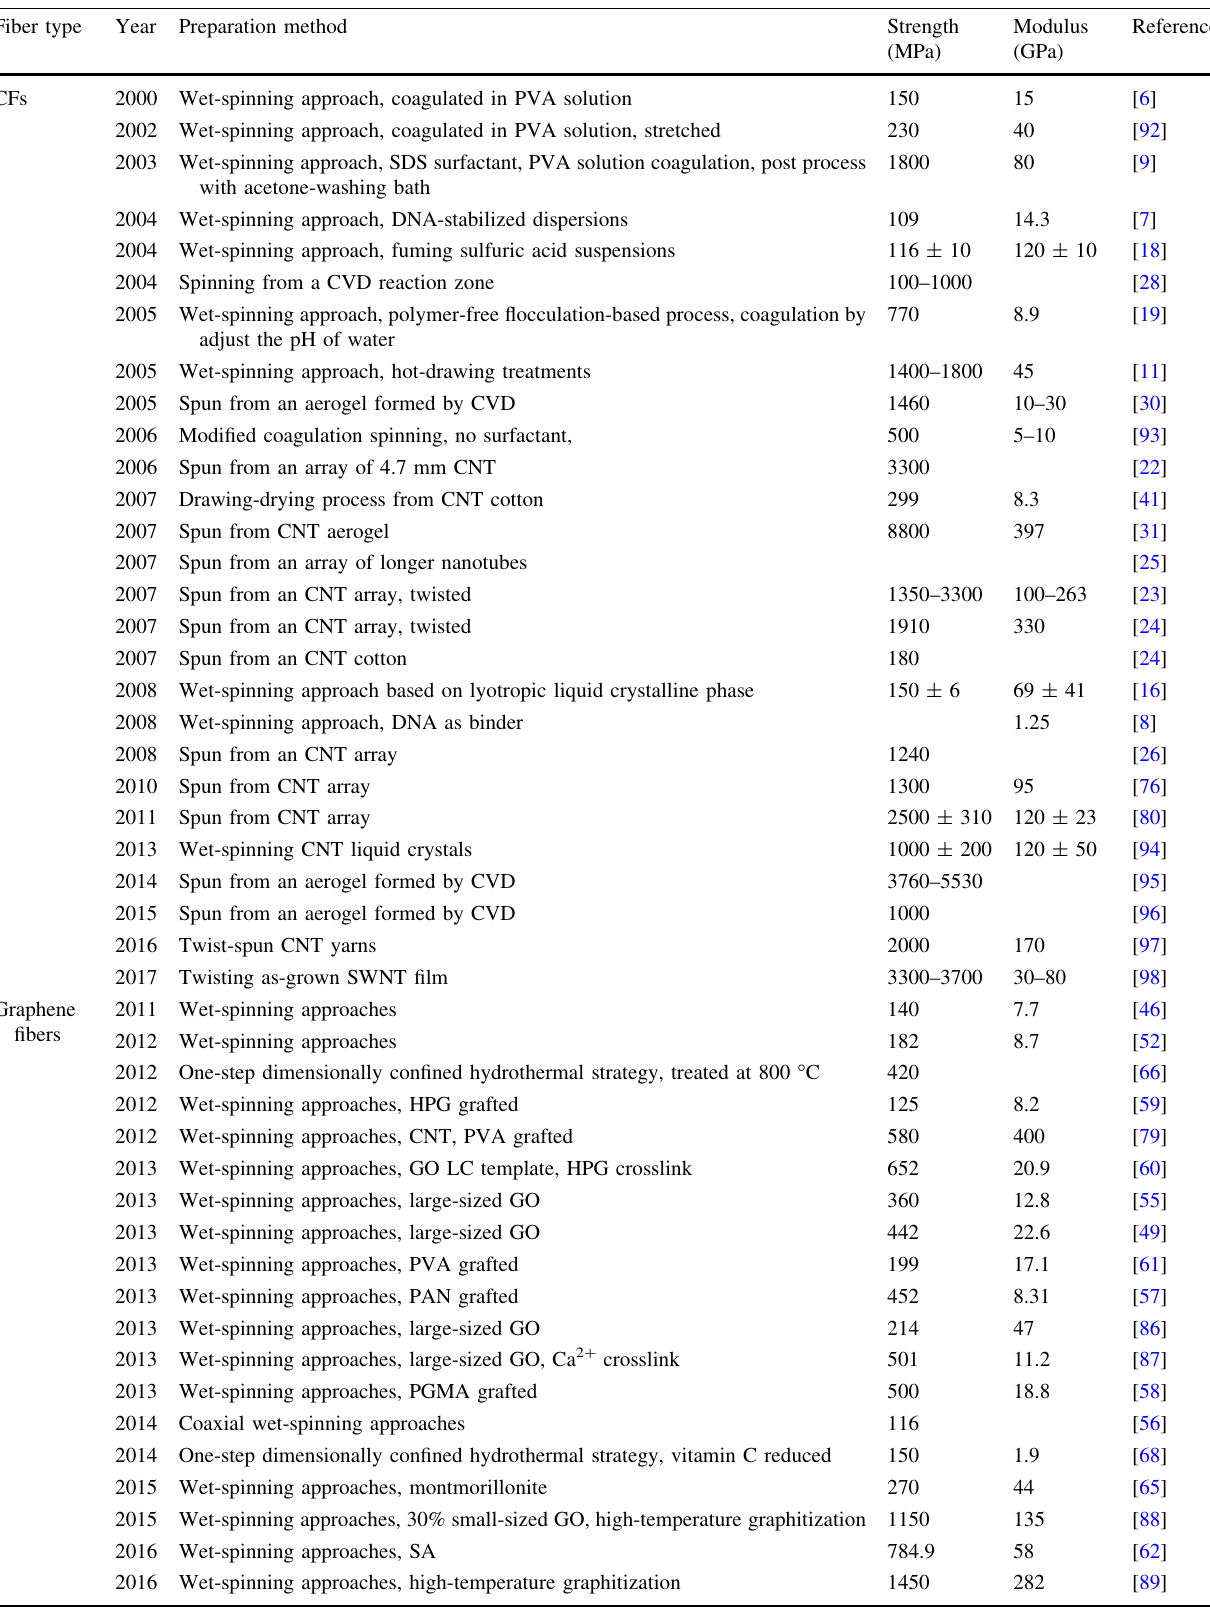
Table 1 Summary of the preparation methods, and mechanical properties of the most relevant CFs Fiber